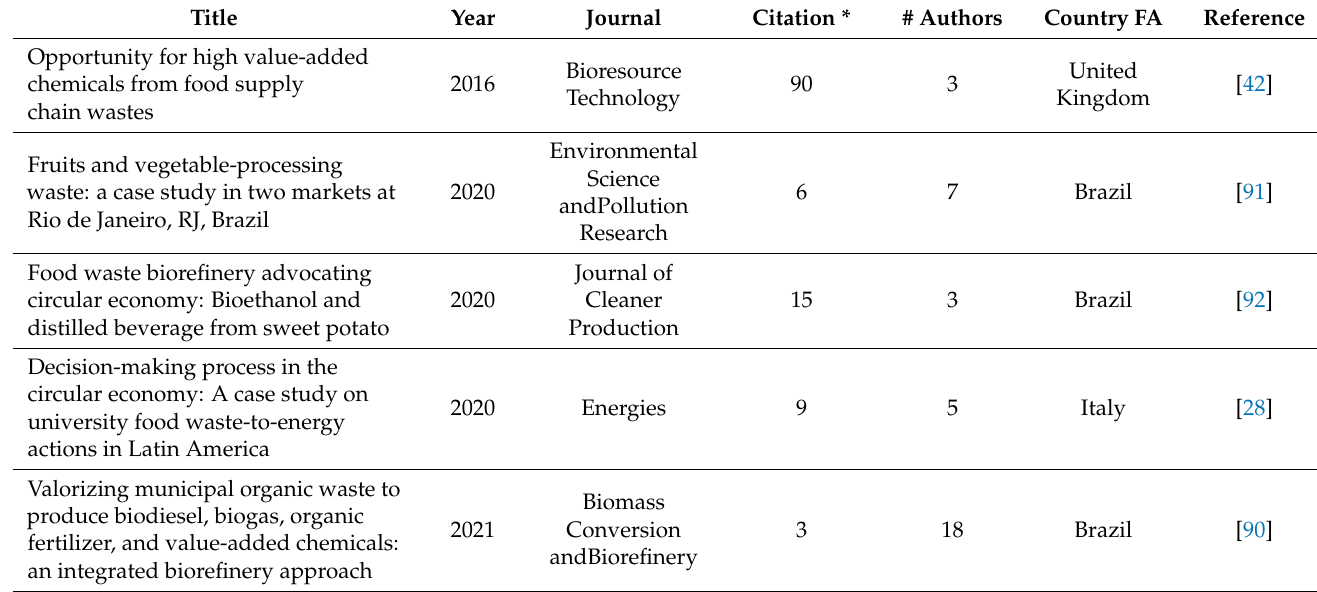
Table 4. Scientific publications with a focus on